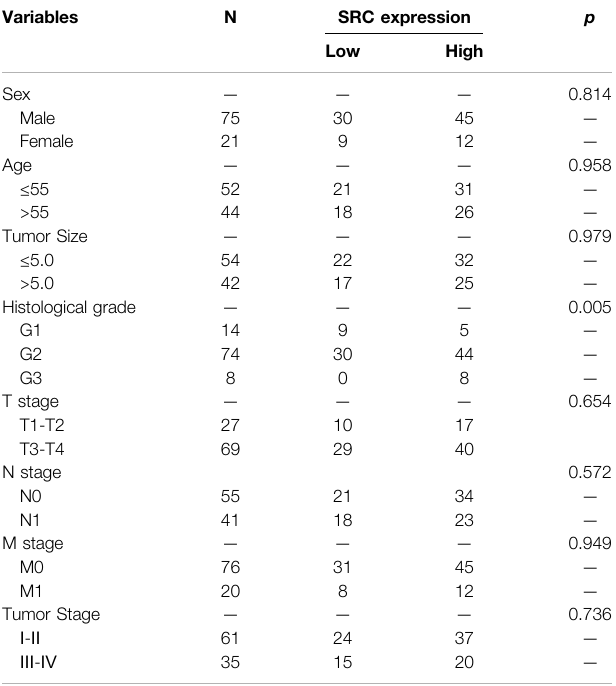
TABLE 1 | Relationships between SRC expression and clinical pathological parameters in ESCC patients. Variables N SRC